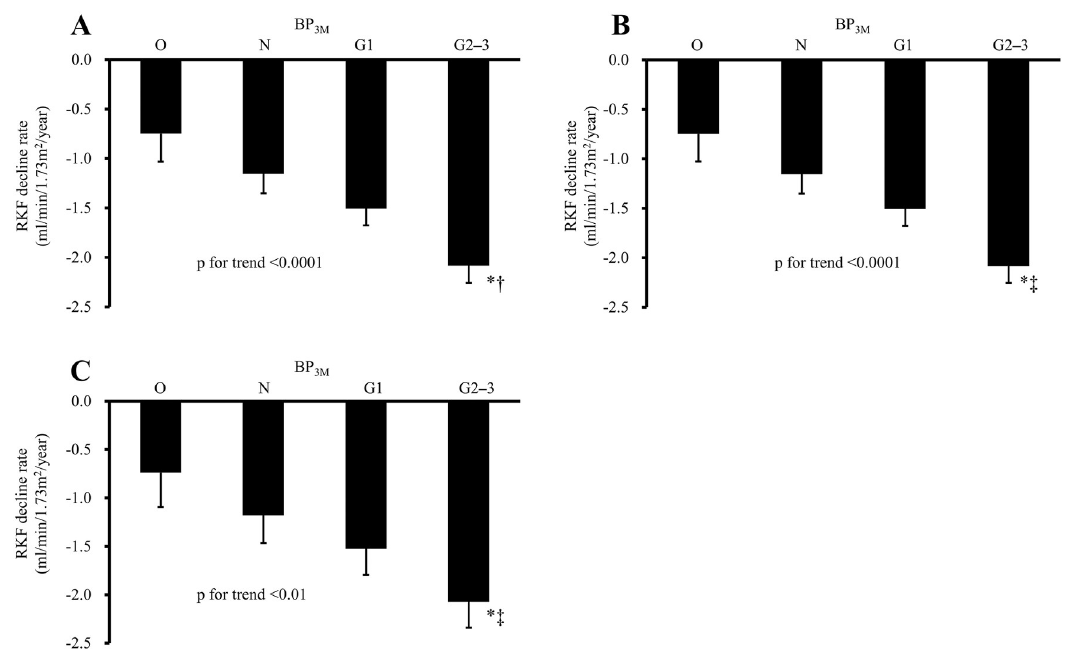
Fig 1. The decline rate of RKF according to the graded BP 3M groups. A : The unadjusted decline rate of RKF among the BP 3M groups. B : The sex- and age-adjusted decline rate of RKF among the BP 3M groups. C : The multivariable-adjusted decline rate of RKF among the BP 3M groups. � p < 0.01 vs. O, †p < 0.01 vs. N, ‡p < 0.05 vs. N. Adjusted for age, sex, diabetes mellitus, previous history of cardiovascular disease, eGFR, hemoglobin, serum albumin, dialysate-to-plasma creatinine ratio at 4 hr, BMI, renin-angiotensin system inhibitors use, icodextrin use, high glucose fluid use, diuretics use, dosage of PD fluid, and peritonitis rate. Error bars indicate the standard error. BP 3M : Blood pressure after 3 months of PD initiation; G1: Grade 1 hypertension; G2–3: Grade 2 & 3 hypertension; N: Normal & High normal; O: Optimal; RKF: Residual kidney